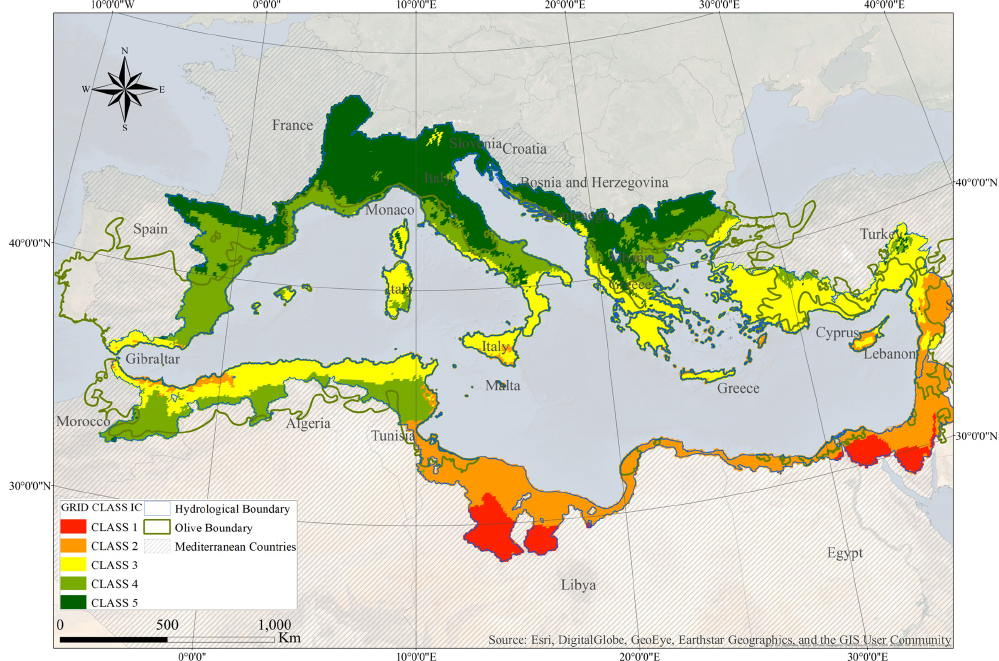
Figure 3. Geographical distribution of the Mediterranean climatic classes based on gridded indices using WorldClim-2 monthly data. Table 5. Gridded classification decision tree accuracy table. The accuracy rate is calculated in comparison to the K -means classification of the gridded indices in Sect.